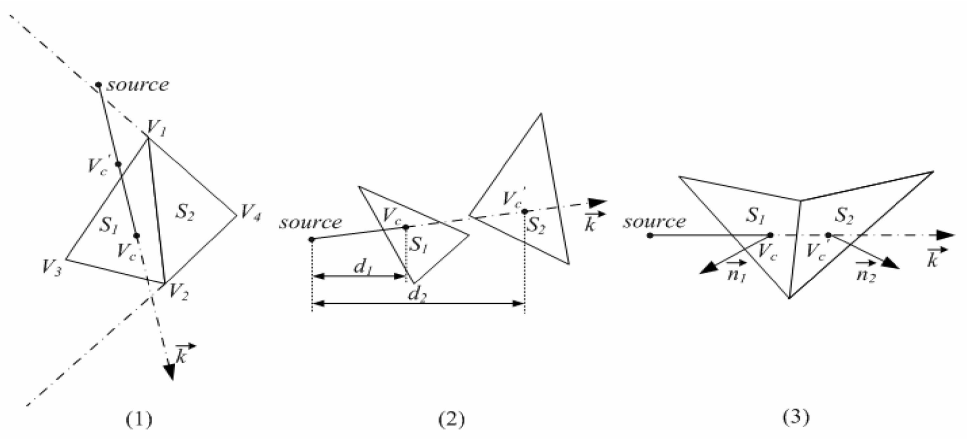
Figure 5. Several methods of surface element occlusion: (1) No occlusion Case; (2) Non-adjacent occlusion case; (3) Adjacent occlusion